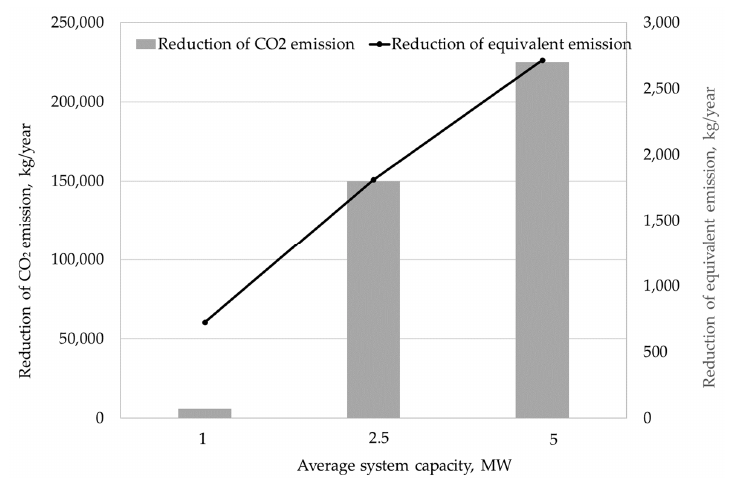
Figure 4. The combined ecological effect as a reduction of the emission of CO 2 and of equivalent emission as the result of implementation of the complete system for improving the energy and ecological efficiency of fuel oil combustion.